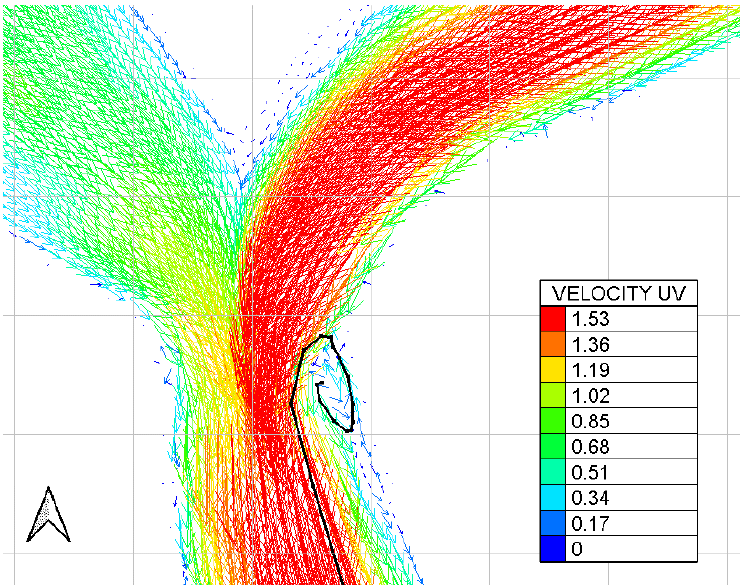
Figure 5. Average flow velocity (VELOCITY UV) in the flood season in 2017 (m/s).